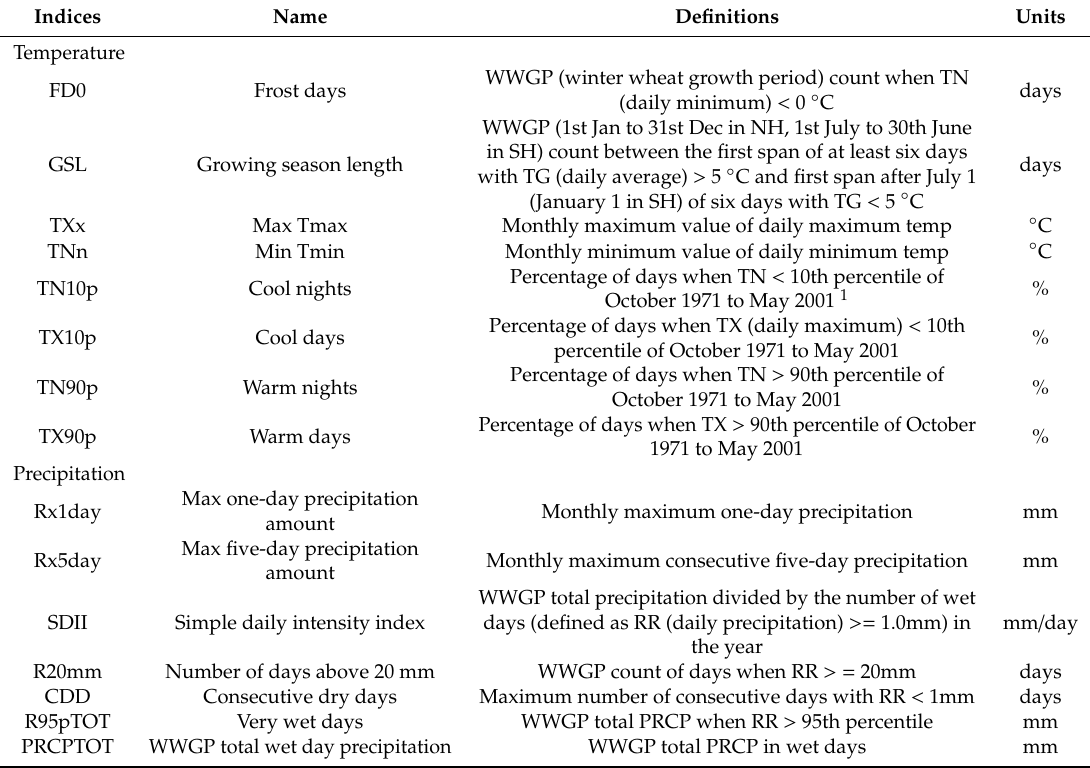
Table 1. List of the extreme temperature and precipitation indices used in this